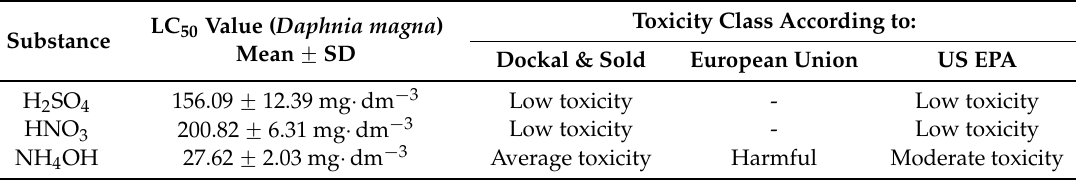
Table 7. Assessment of acute toxicity of pollutants on Daphnia magna (LC 50 /24 h).